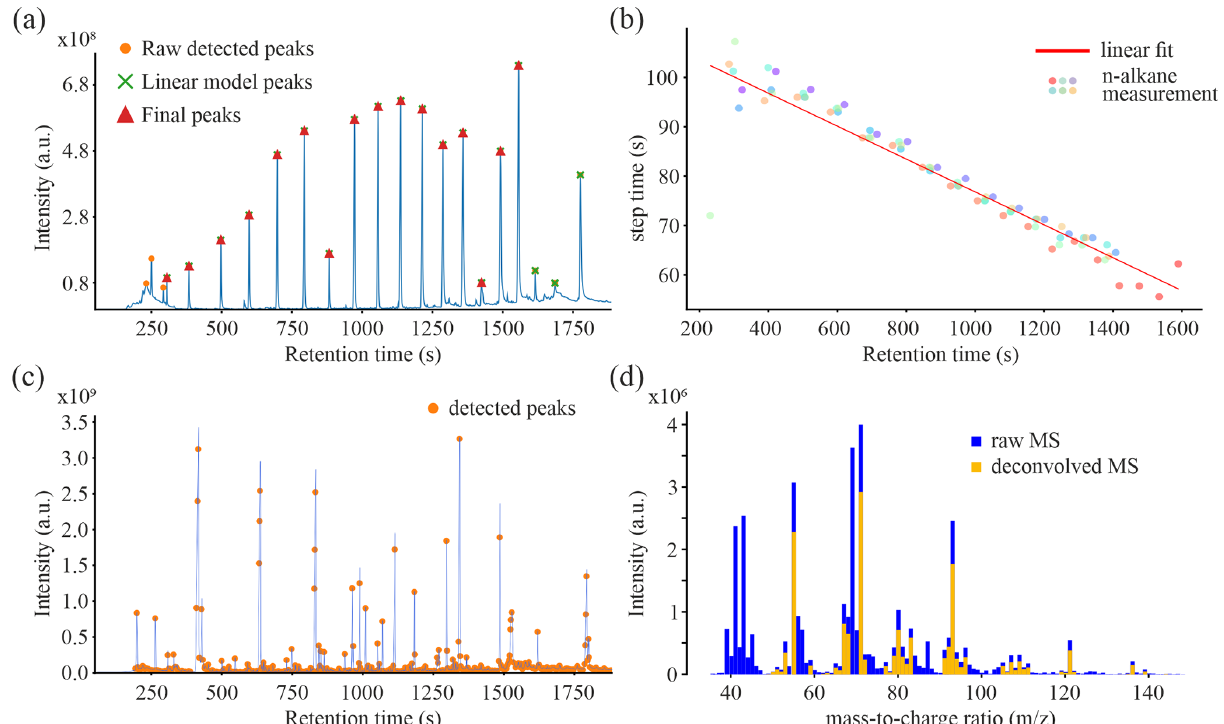
Figure 2. Overview of the alkane and sample peak detection and spectral deconvolution process. (a) Exemplary alkane reference run with detected alkane peak times and intensities. (b) Plot of several detected alkane peak times and time steps to the next detected alkane. (c) Exemplary sample run with detected peak times and intensities. (d) Exemplary mass spectrum before and after